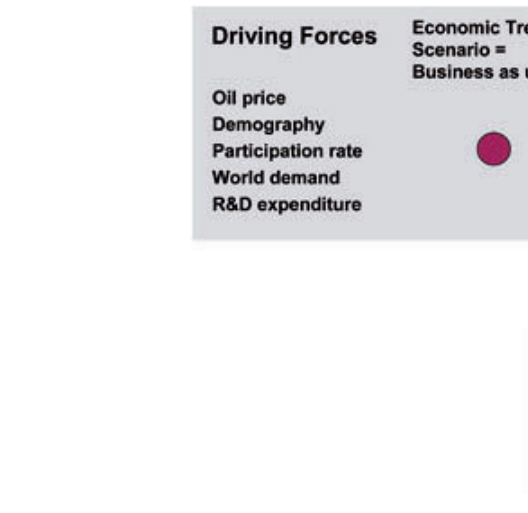
Fig. 2. Scenario design in the analytical approach: a suite of five socioeconomic driving forces constitute an economic trends scenario (upper left), which describes the reference for the choice of policy scenarios to act upon (upper right). Together they determine the land use change scenarios (lower